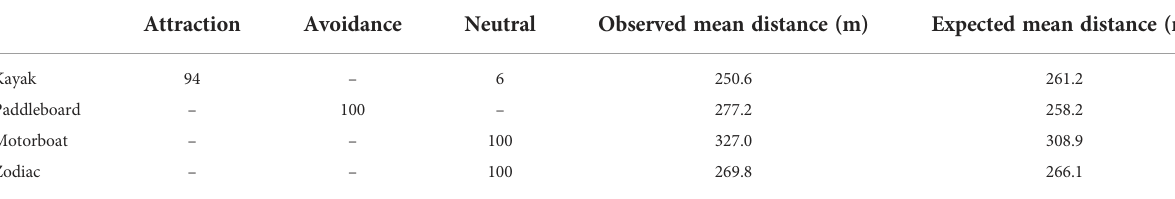
The mean observed and the modal mean of the expected distances based on 100